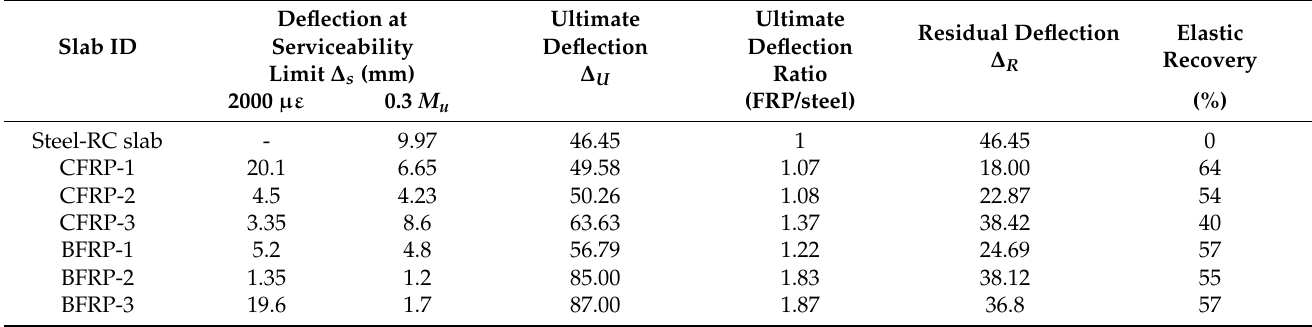
Table 6. The ultimate and residual deflections of the